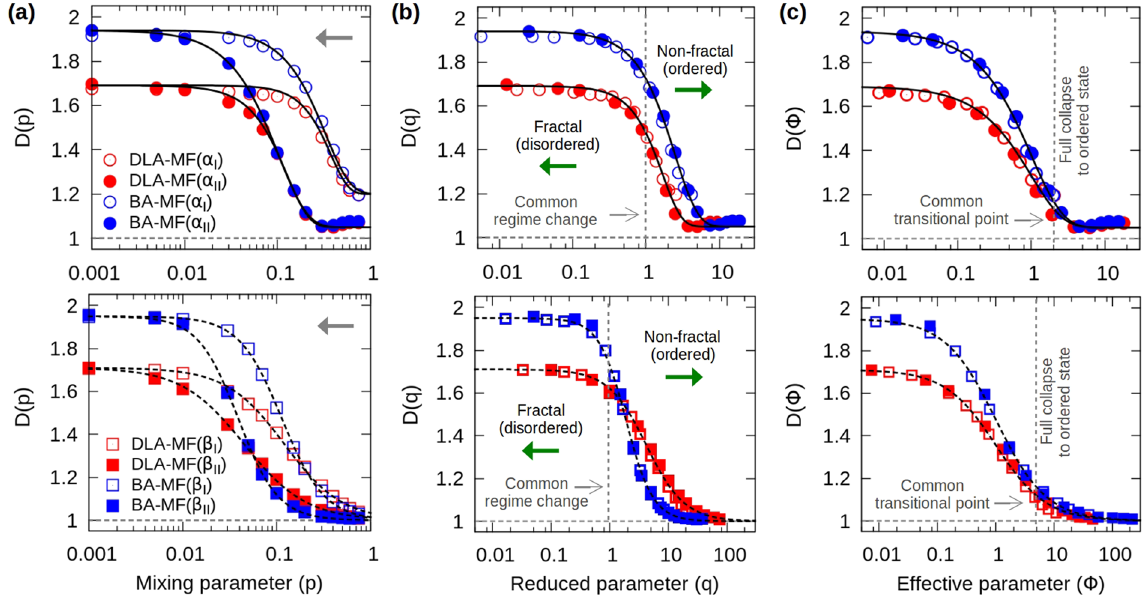
Figure 3. Scaling analysis of the BA/DLA-MF transitions. ( a ) Local scaling, D ( p ), of the DLA-MF and BA-MF transitions obtained from C ( r ) [top], at small ( α I ) and large ( α II ) scales, and R g ( N ) [bottom], at medium ( β I ) and large ( β II ) scales, according to Fig. 2c,d (see Methods). These results are described by the solid and dotted curves given by equation (2) [top] and (3) [bottom], respectively, for different values of the parameters Λ and χ . The arrows indicate the direction of increasing scale. ( b ) By plotting D as a function of q = p / p i (where p i is calculated for each curve), all the data collapse into single master curves, D ( q ), according to equations (2) [top] and (3) [bottom], with a common point of regime change at q i = 1. The arrows indicate the direction in which the fractal or non-fractal features of the clusters are enhanced. ( c ) Plots of D as a function of the effective parameter Φ . Notice how all of the transitions approach common transitional points where clusters have already fully collapsed to linear ≈ D ( 1) structures, independently of the stochastic model used. Details of the values for the parameters used can be found in Table 2.